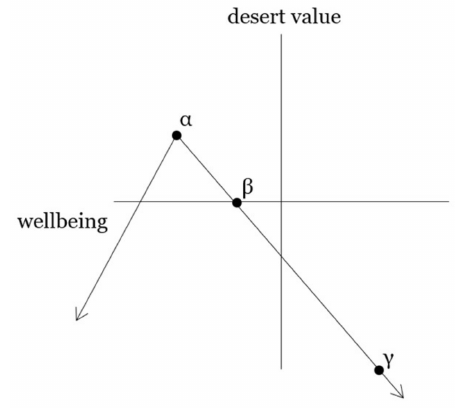
Figure 1. Hitler’s desert